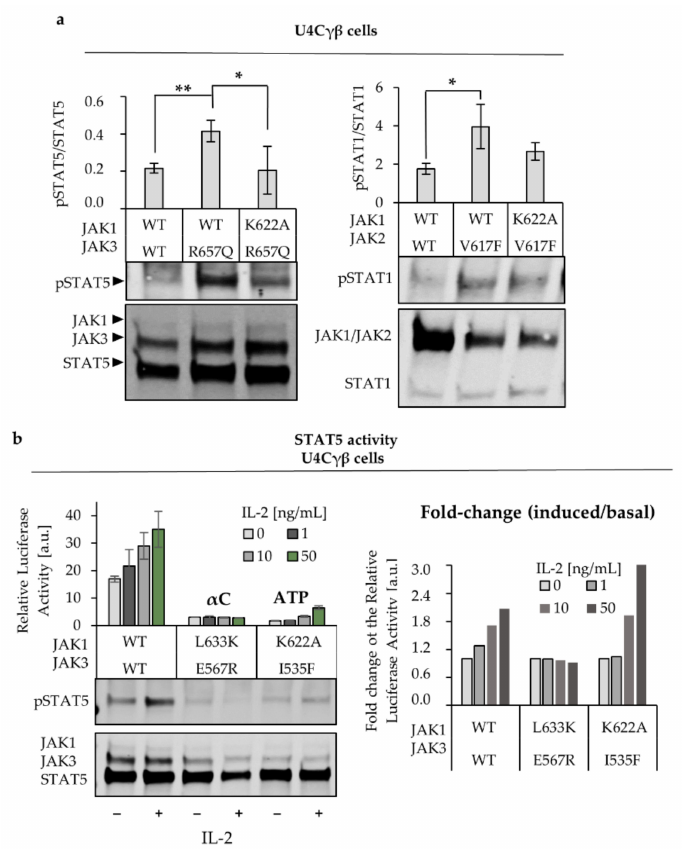
Figure 5. Characterizing the cumulative e ff ect of the JAK JH2-mutants. ( a ) JAK1 K622A had variable reduction potential towards hyperactive JAK3 R657Q or JAK2 V617F. pSTAT1 / 5 was detected from cells transfected with HA-JAK1 and JAK3 or JAK2. The lysed cells were blotted to a membrane and labelled with HA, STAT1, and pSTAT1 / 5 antibodies as prescribed previously. Errors are SD of triplicate experiments. Two-tailed student t -test was performed between the WT and K622A in JAK3 R657Q background and indicates as * ( p < 0.05) or ** ( p < 0.001). ( b ) JAK1 and JAK3 with homologous JH2 α C mutations were co-transfected into U4C γβ cells, which show abolishes IL-2 signaling. Similar setting with JAK1 and JAK3 ATP-site mutants can weakly respond to stimulation with 100 ng / mL of IL-2. STAT5-responsive plasmid was transfected as previously with JAK1 and JAK3 α C and ATP site mutants and after 43 h an increasing amount of cytokine was added into cells or the cells were only starved. Relative luciferase values of triplicates were detected and error are SD. Below : pSTAT5 analysis of cells transfected with JAK1 and JAK3 and treated, or not, with 50 ng / mL of IL-2. Right : the values shown in left were normalized to the basal values for each mutant (and WT) pair to show the fold change between the unstimulated and stimulated